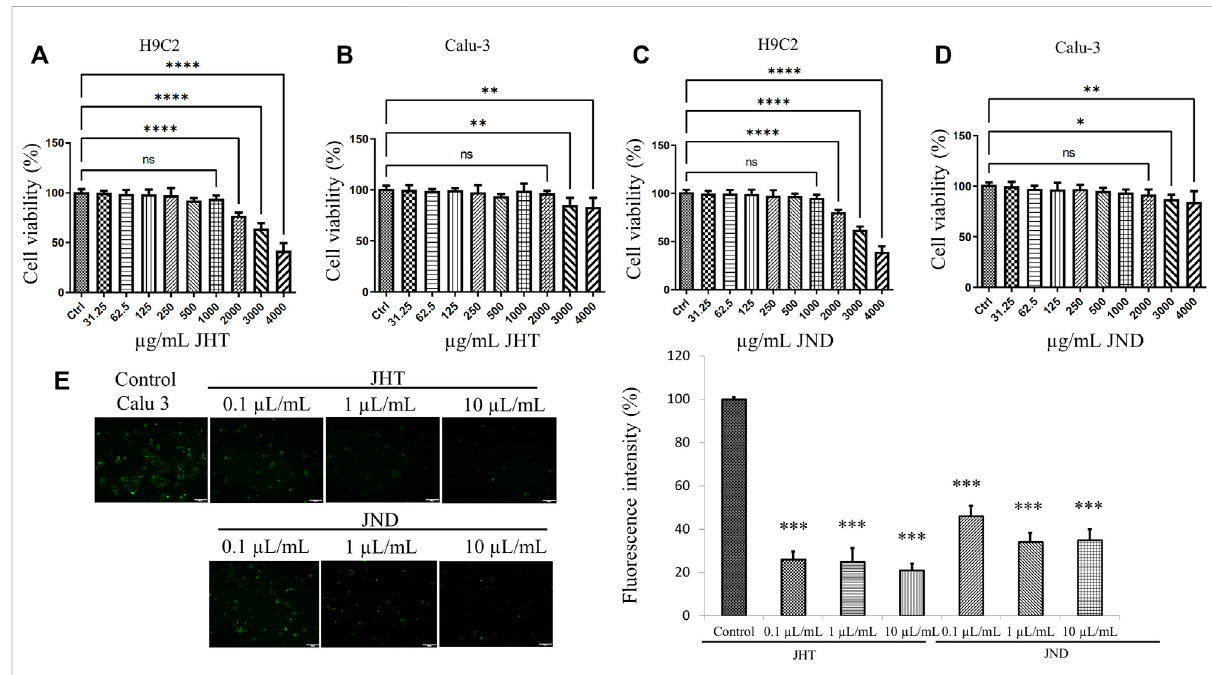
Cytotoxic evaluation of JHT and JND and their effects on SARS-CoV2-S-pseudotyped lentivirus penetration in ACE receptor-rich Calu-3 cells. Cytotoxicity of JHT (A , B) and JND (C , D) was evaluated by MTT assay in H9c2 (A , C) cells and in Calu-3 cells (B , D) . Calu-3 cells infected with